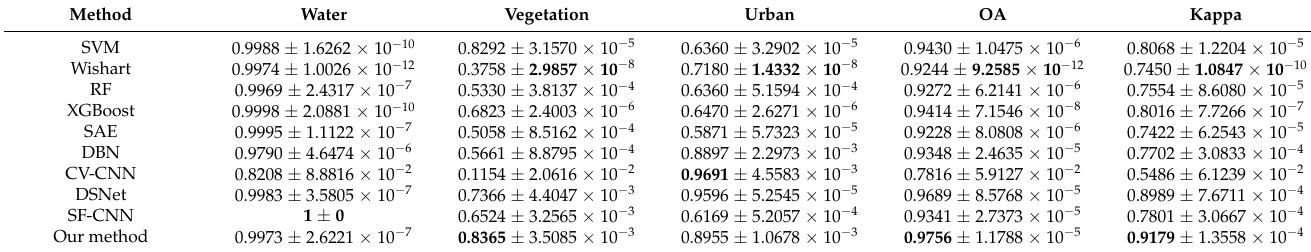
Table 3. Classification Results of Flevoland with Different Methods, where the highest mean and lowest variance for each category are marked in bold.